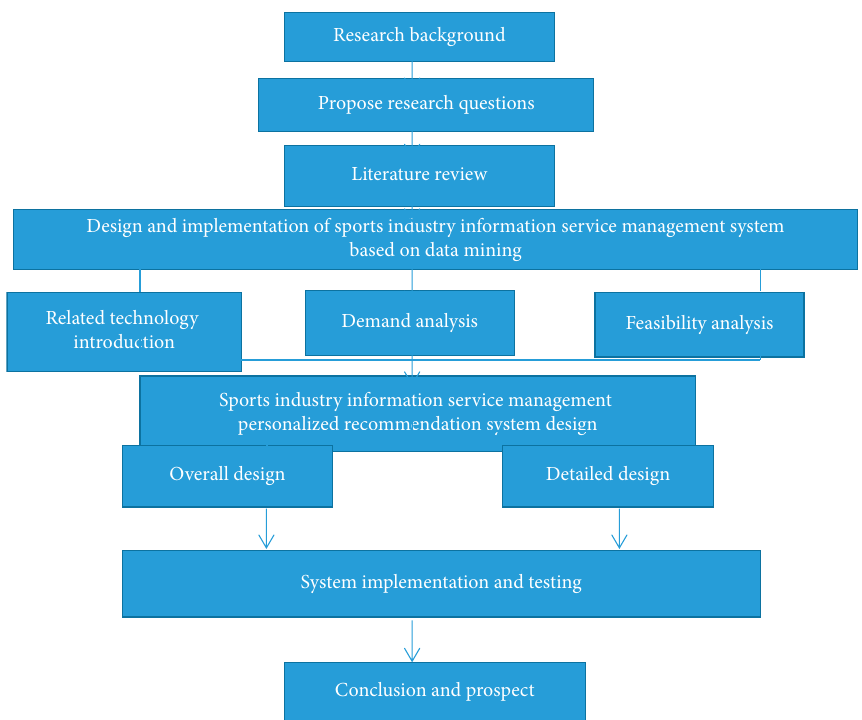
Figure 2: The framework of the